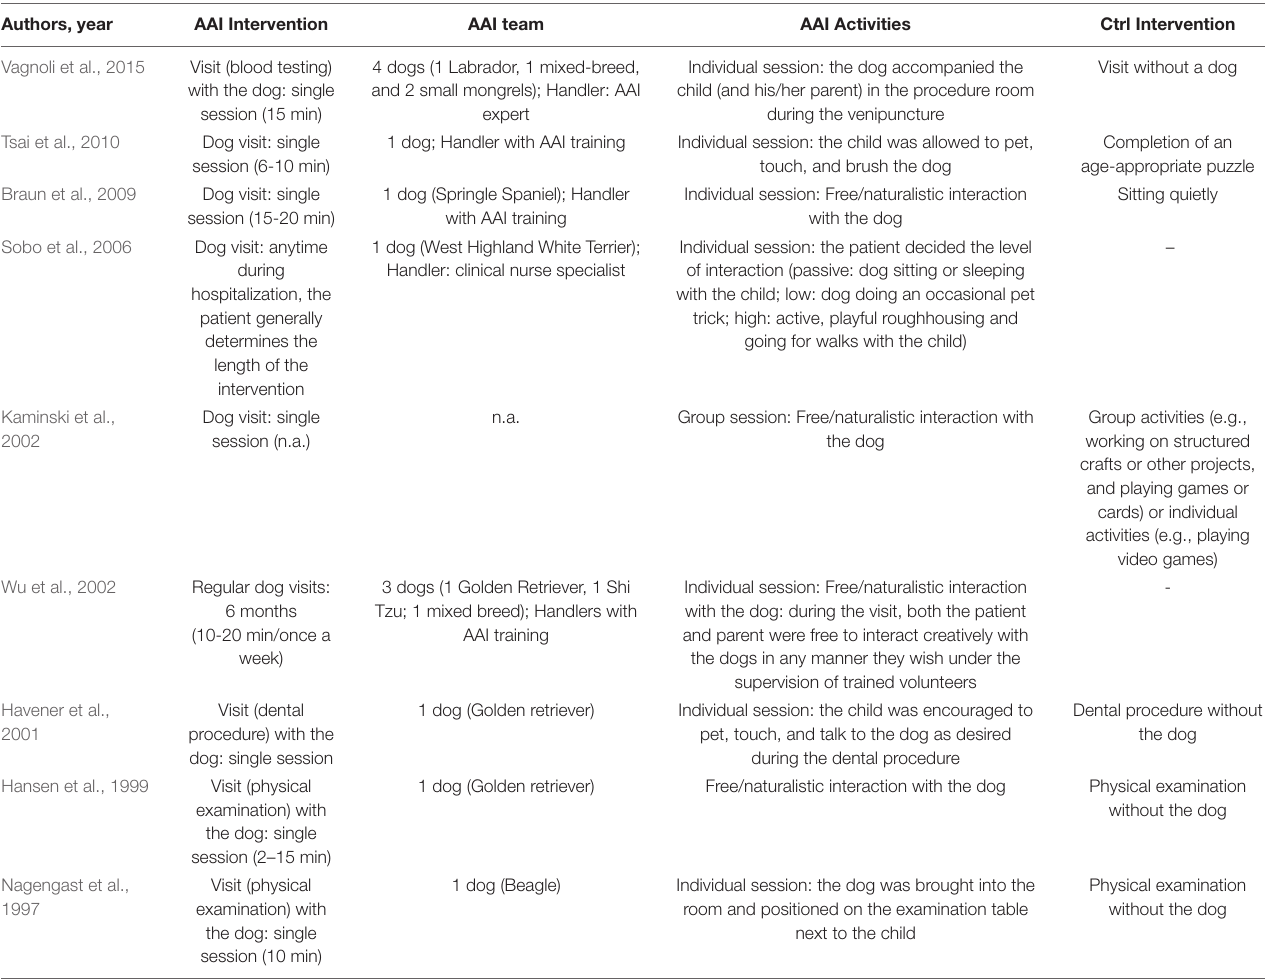
Individual session: the dog was brought into the room and positioned on the examination table next to the child